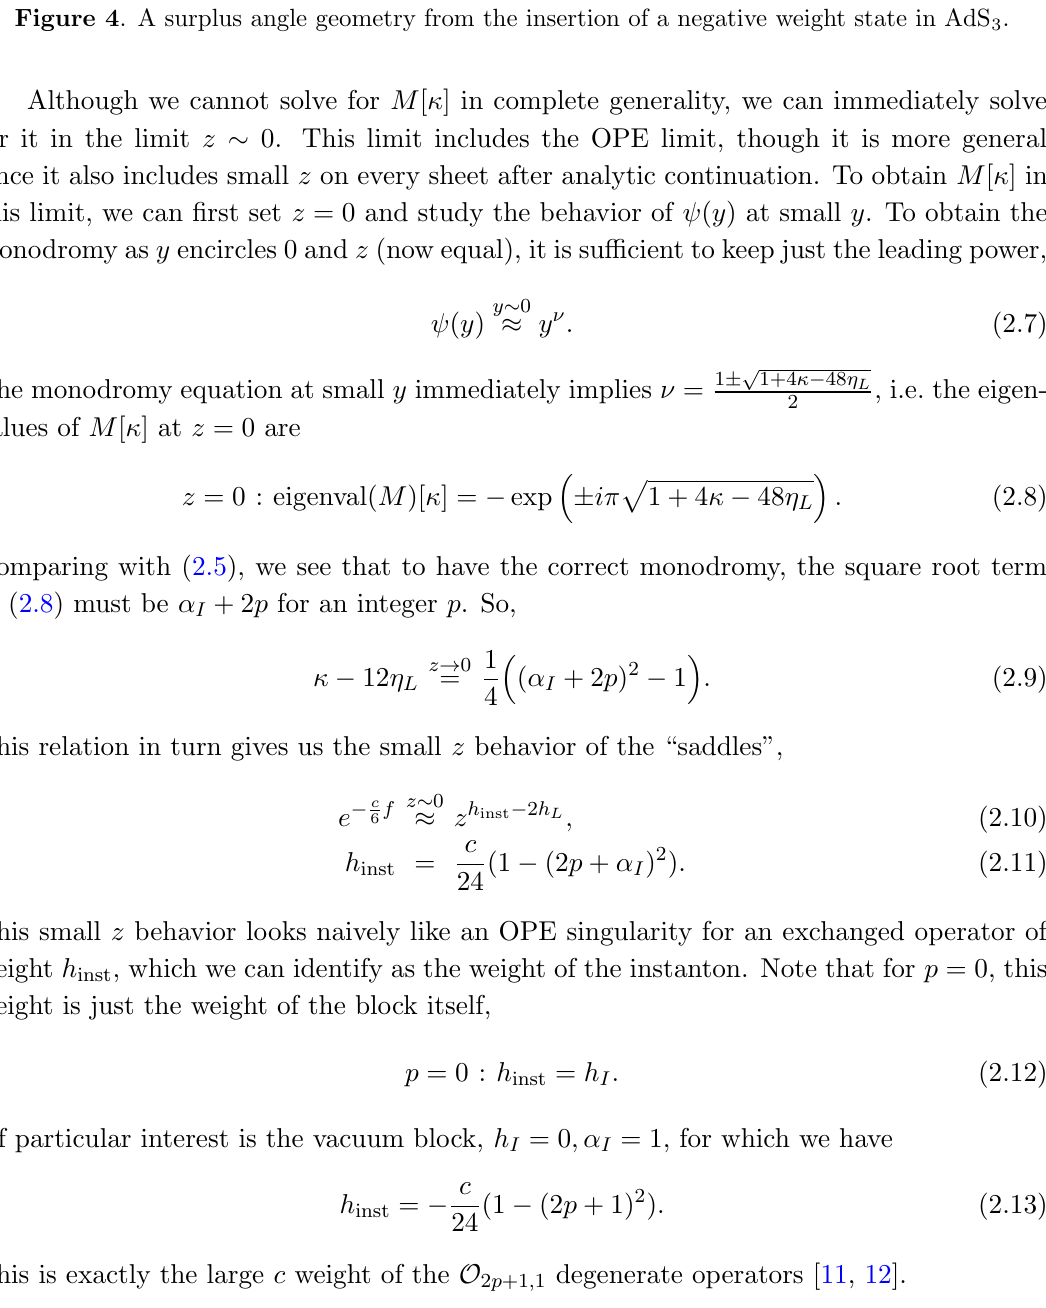
Figure 4 . A surplus angle geometry from the insertion of a negative weight state in AdS 3